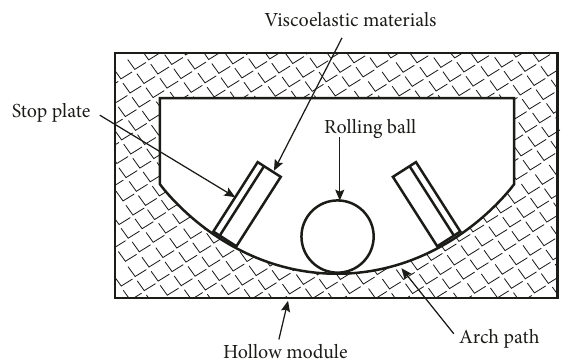
Figure 2: Schematic diagram of